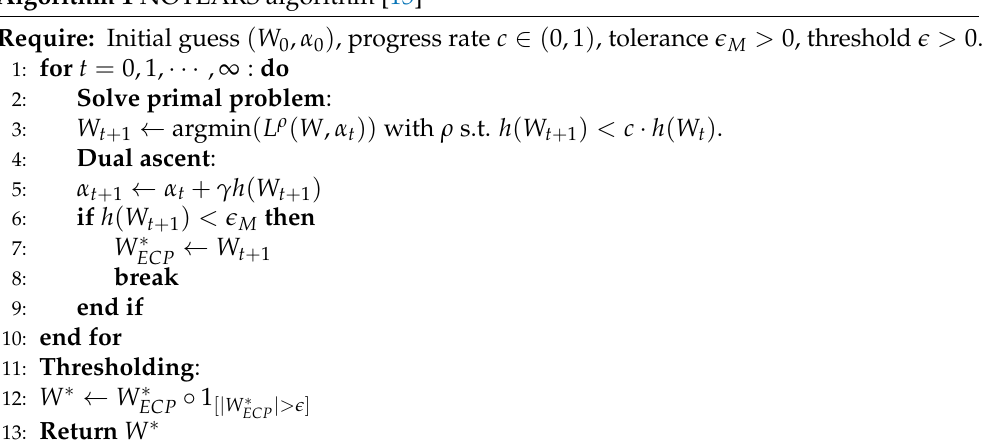
Algorithm 1 NOTEARS algorithm